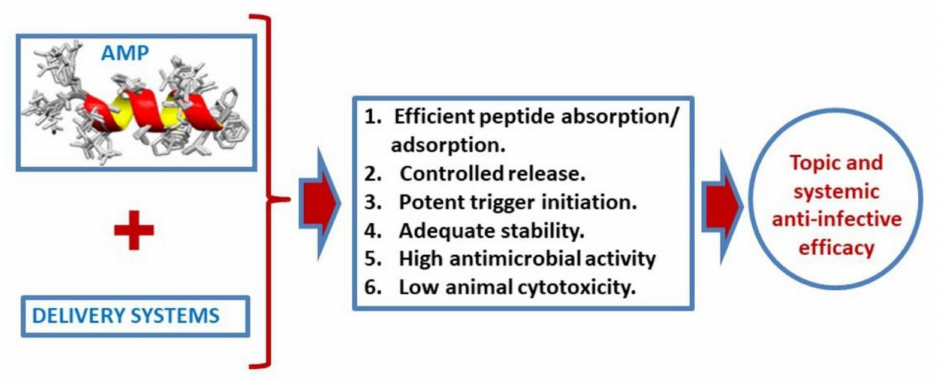
Figure 4. Some platforms and carriers for AMP release systems.